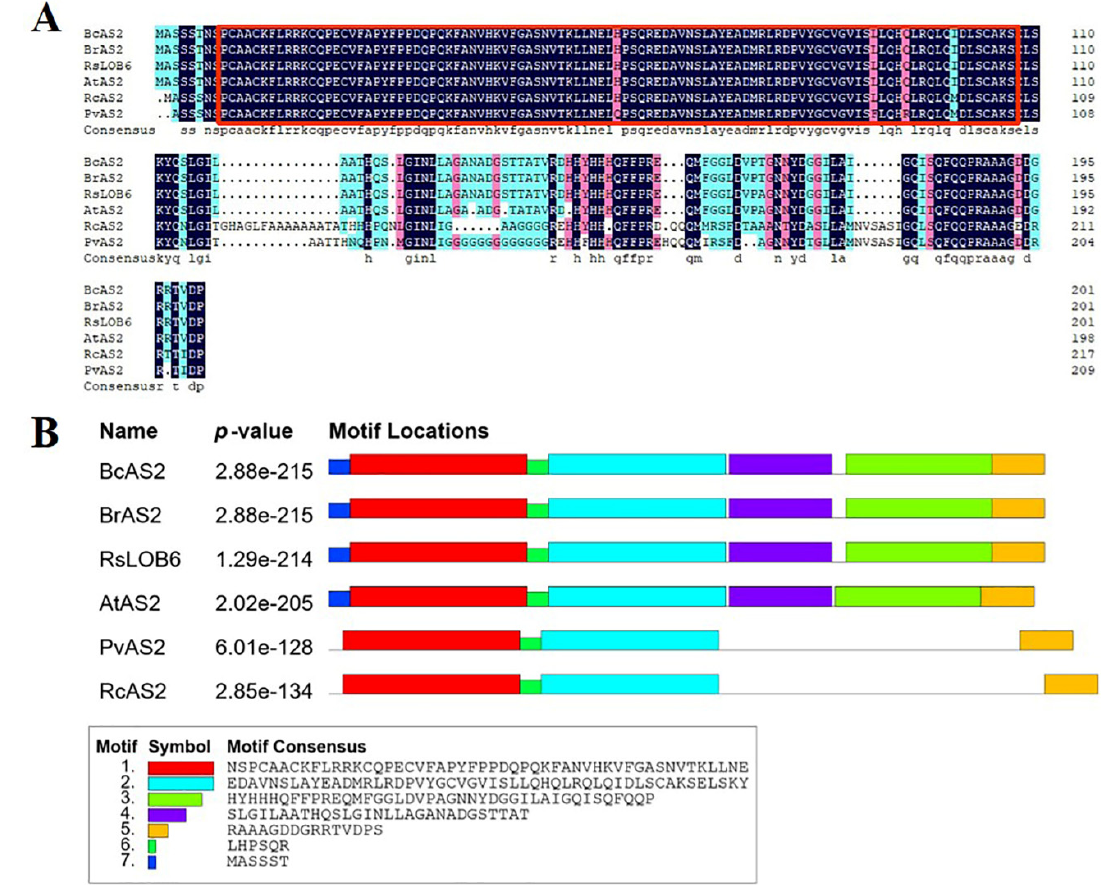
Figure 1. The sequence analysis of BcAS2 protein. ( A ) The multiple sequence alignment of BcAS2 protein with AS2-like proteins in Brassica rapa (BrAS2, XP_009127444.1 ) , Raphanus sativus (RsLOB6 , XP_018468477.1 ) , Arabidopsis thaliana ( AtAS2, NP_001077777.1), Pistacia vera (PvAS2, XP_031287864.1 ) , Ricinus communis ( RsAS2, XP_002514766.1). The red box contained the LOB conserved domain in different species. ( B ) The motif analysis of BcAS2, the relevant sequence information is shown at the bottom of the figure, the p -value represents the significance of each motif.